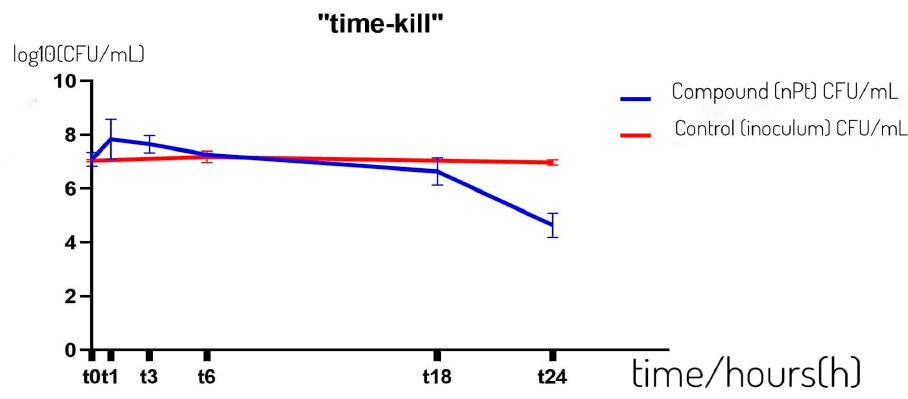
Figure 1. Number of colonies of Klebsiella pneumoniae ESBL+ MFBF 10690 over time (h) treated with nPt (c = 2 × MIC) relative to the control. CFU—colony forming unit; t—time.